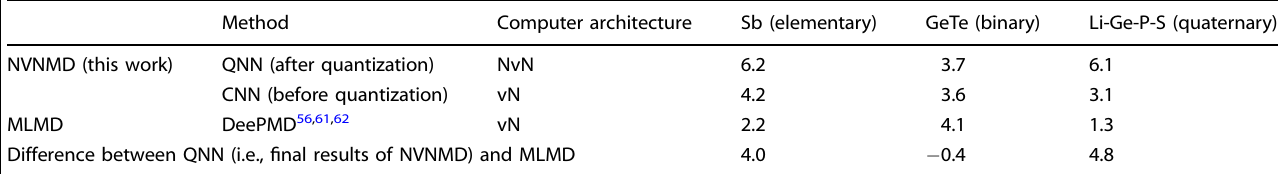
Table 2. The root mean square errors (RMSE) of system energies (meV atom − 1 ) of the three bulk